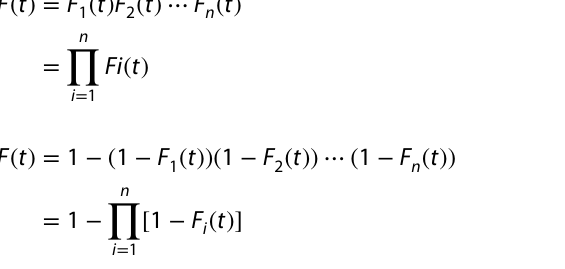
Bold value indicated influence on the probability of the top event is very